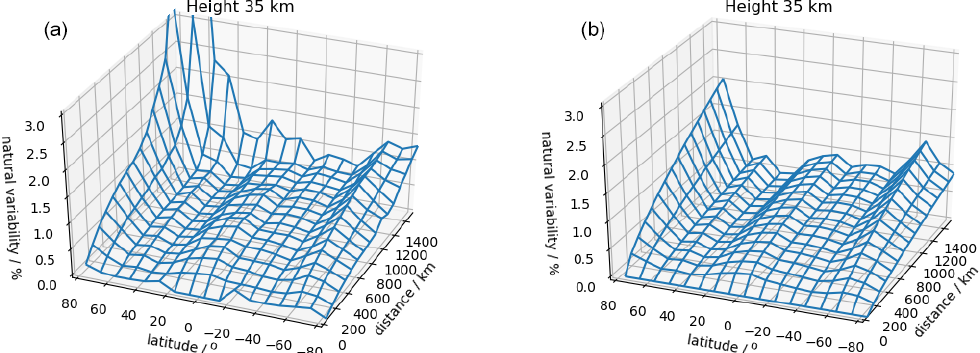
Figure 4. Natural variability of O 3 at 35km altitude as a function of horizontal distance separation in the BASCOE model for the (a) model fields and (b) regressed